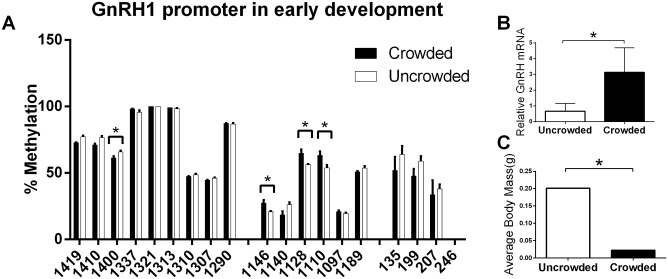
Social crowding results in hypomethylation and silencing of the GnRH1 gene and decreased body mass
(A) Bisulfite map of methylation in the GnRH1 gene and 1.5kb upstream of its transcriptional start site (TSS) from uncrowded (white) and crowded mothers (black) (B) Relative expression of GnRH1 from 14-day-old fry following gestational crowding. (C) Body mass seen in 42-day-old fry following gestational and developmental crowding. * = p<0.05. (n = 5–7 /group). Error bars represent s.e.m. Unpaired student’s T-test.